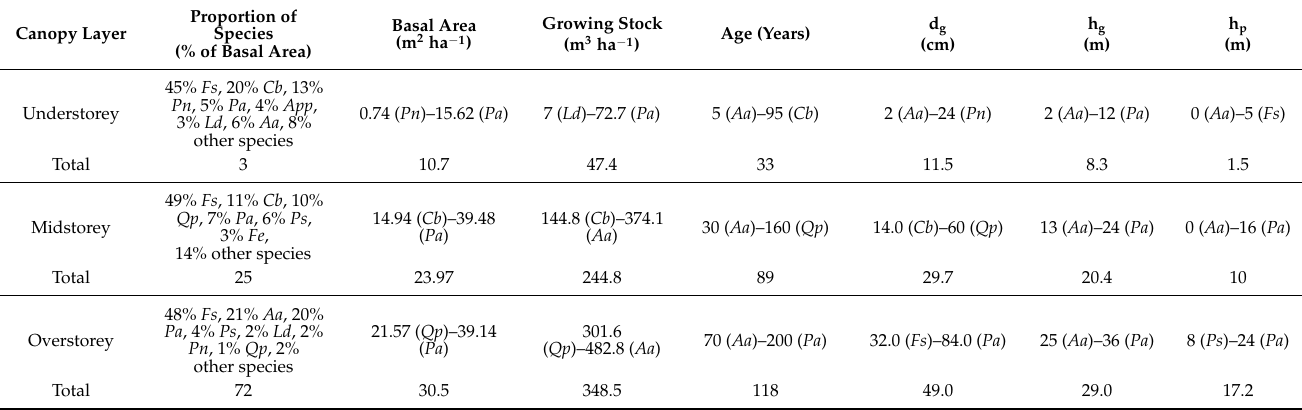
Table 2. Characteristics of the forest, differentiated by canopy layer (overstorey, midstorey, and